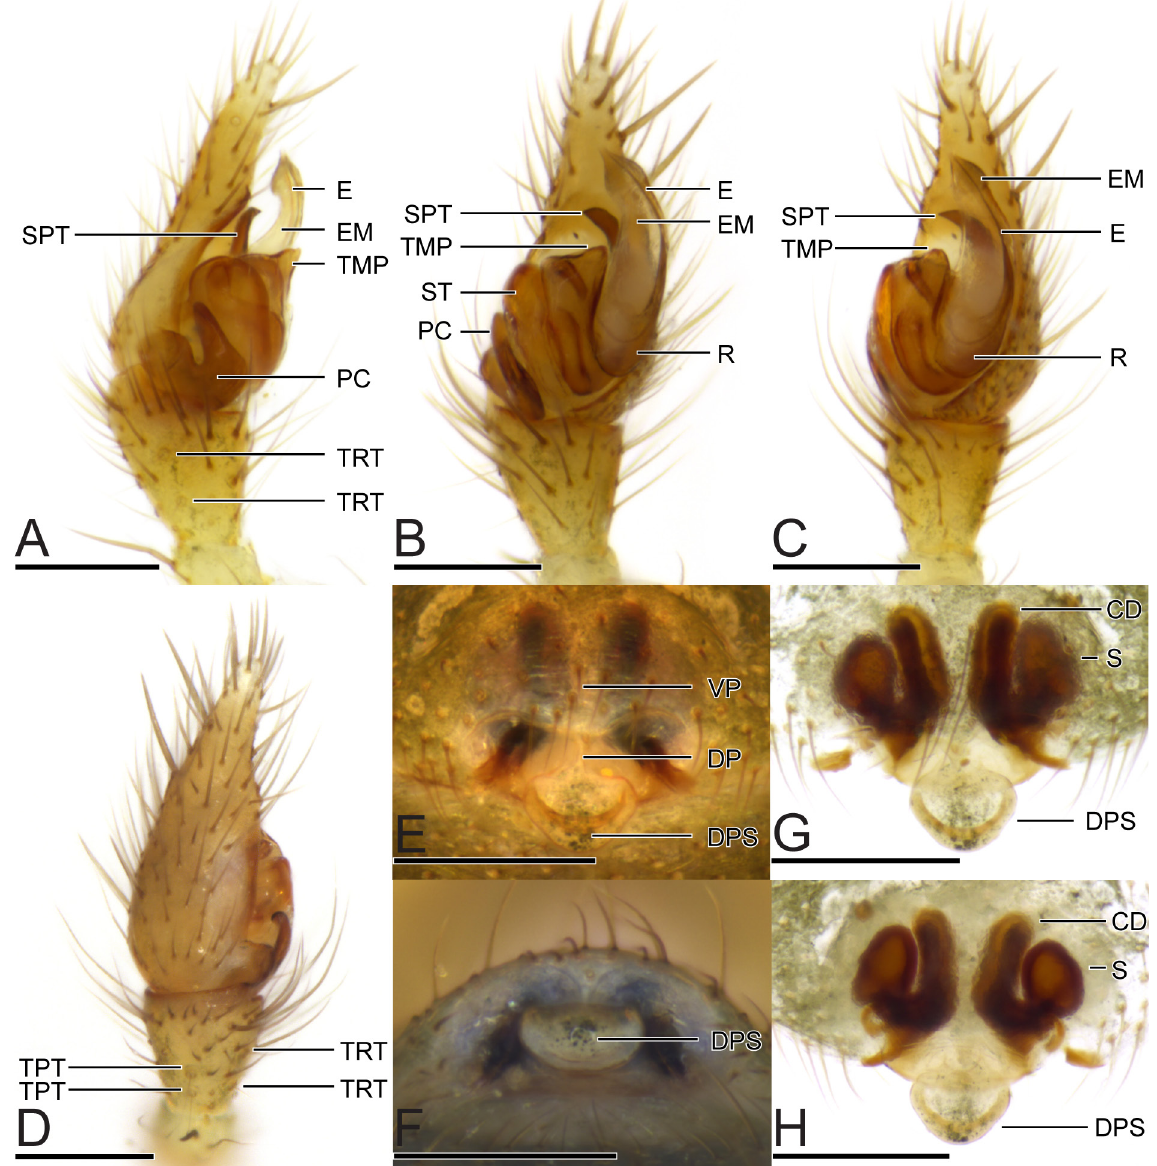
Fig. 2. Camafroneta oku gen. et sp. nov. A–D . Holotype, ♂ (ZMUC00046889). A . Palp, retrolateral. B . Ventral. C . Prolateral. D . Dorsal. E–H . Allotype, ♀ (ZMUC00046889). E . Epigyne, ventral. F . Aboral. G . Cleared vulva, ventral. H . Dorsal. Scale bars: 200